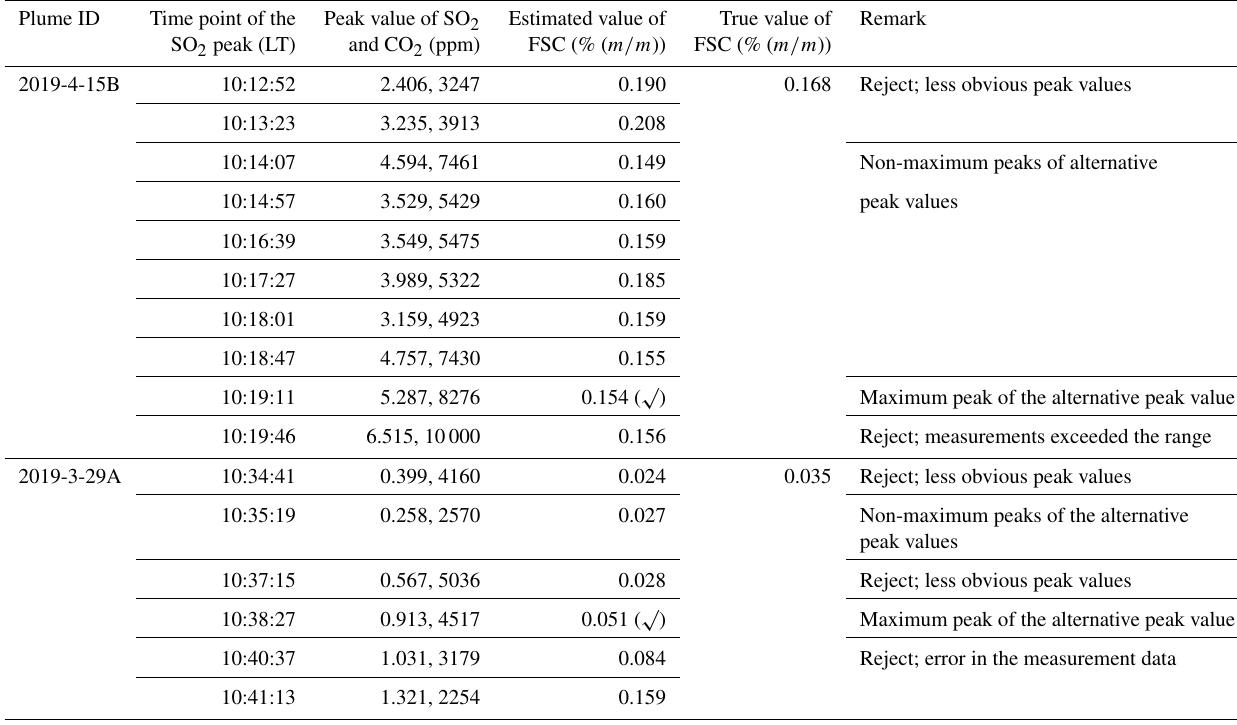
Table 2. All peak values and their corresponding FSC results. The background values of plume 2019-4-15B were 0ppm and 310ppm for SO 2 and CO 2 , respectively. The background values of plume 2019-3-29A were 0 and 329ppm for SO 2 and CO 2 , respectively. The remarks indicate the reason for choosing or not choosing the peak. It can be seen that the peak value of plume 2019-4-15B was more obvious and that the results obtained by multiple alternative peaks were similar. The peak of plume 2019-3-29A was less obvious and there were fewer alternative peaks. This was also the basis for distinguishing data as being good or poor quality. The FSC result of selected peak values are √ marked as “ ”. As the sensor response time was inconsistent, only the SO 2 peak time points are listed (the CO 2 peak time points had a delay of several